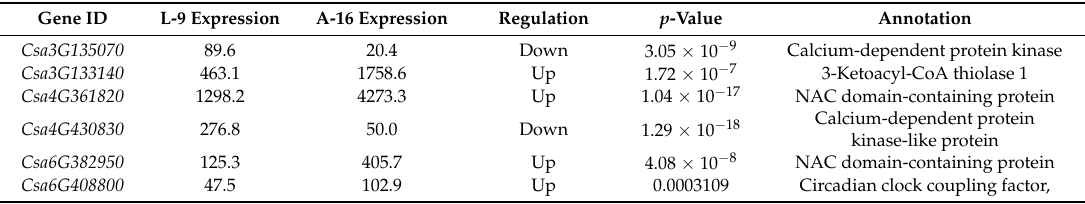
Table 3. Genes involved in ABA signaling